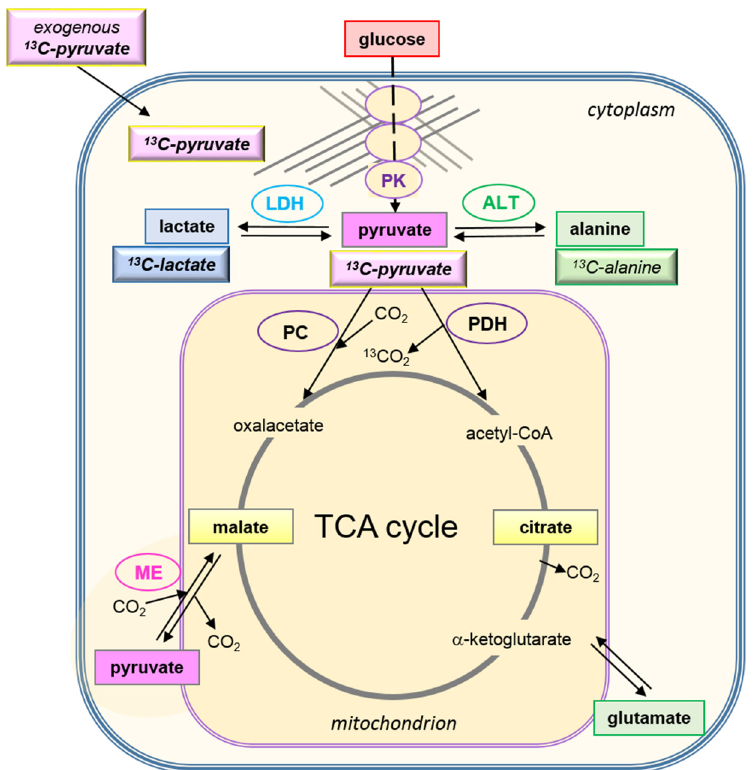
Figure 9. Metabolic fates of exogenous and intracellular pyruvate. Metabolic scheme for the fate of exogenous [1- 13 C]pyruvate in the cell. The crossed line pattern represents cytoskeletal structures to which glycolytic enzymes are bound, forming a metabolic micro-compartment (glycolytic metabolon). Upon uptake of hyperpolarized [1- 13 C]pyruvate into the “cytosolic” space, LDH and ALT1 could be direct enzymes for pyruvate conversion. The correlation of k pl with the glycolytic flux suggests that those LDH complexes associated with the glycolytic metabolon are the ones mainly responsible for the hyperpolarized [1- 13 C]pyruvate-to-[1- 13 C]lactate conversion. However, pyruvate could be also channeled into mitochondria, to other enzymatic reaction sites, namely those of PDH and pyruvate carboxylase, as well as to LDH, the latter also localized in peroxisomes (not shown; [65,66], depending on the metabolic program of the cancer cell. In the case of [1- 13 C]pyruvate, upon decarboxylation to acetyl-CoA, the 13 C-label is detached as 13 CO 2 . In contrast, both 13 C-citrate and 13 C-malate can be detected upon metabolization of [U- 13 C 6 ]glucose, as shown in Figure 8. PK: pyruvate